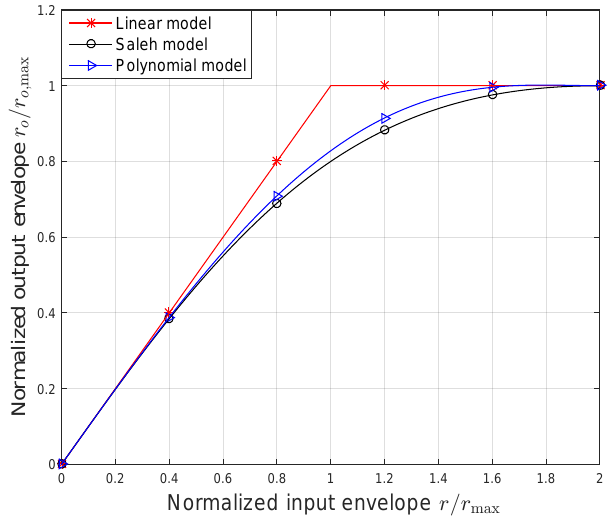
Figure 4. Normalized AM-AM